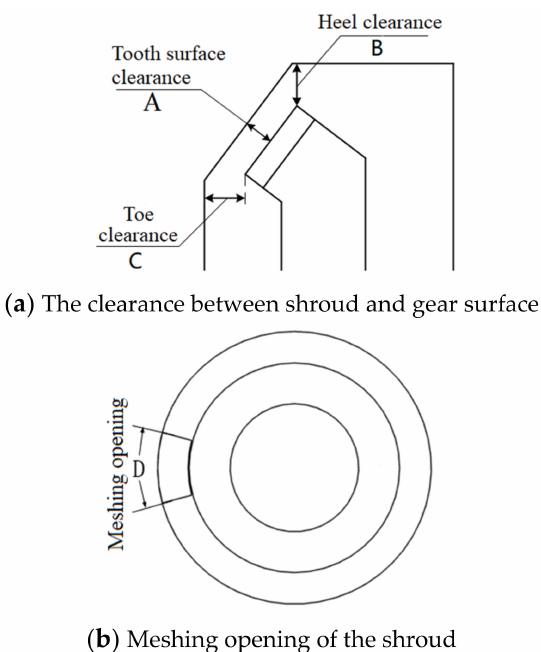
Figure 10. Schematic diagram of test factors.